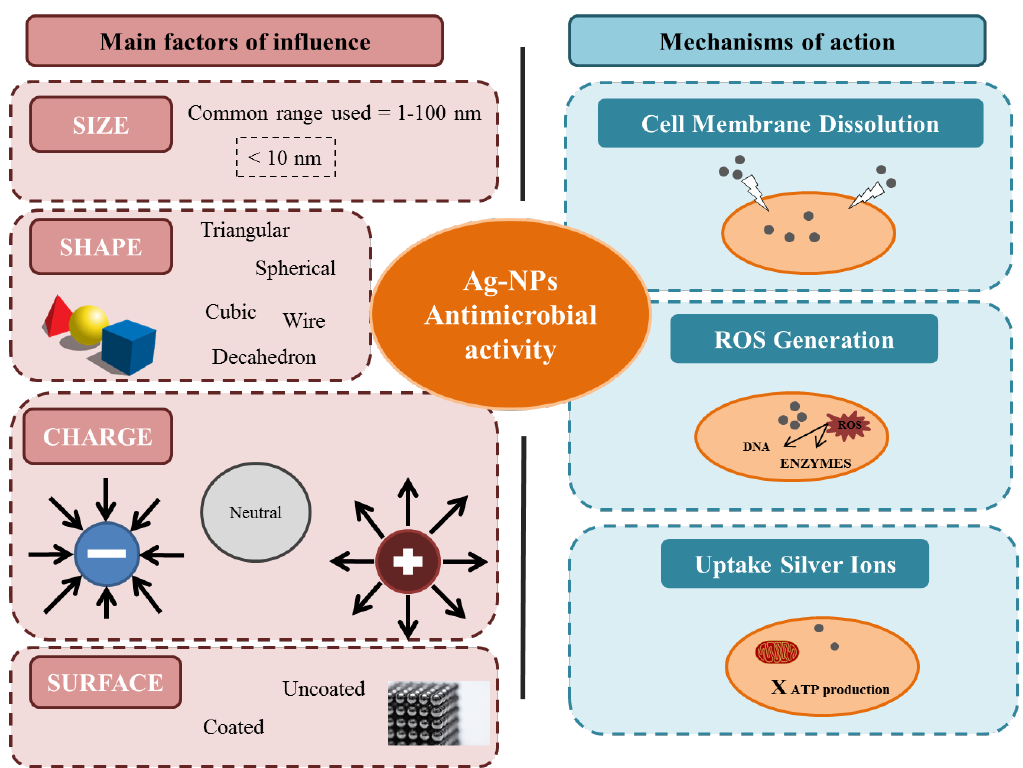
Figure 1. Main factors of influence and hypothetical mechanisms for the antimicrobial activity of silver nanoparticles.